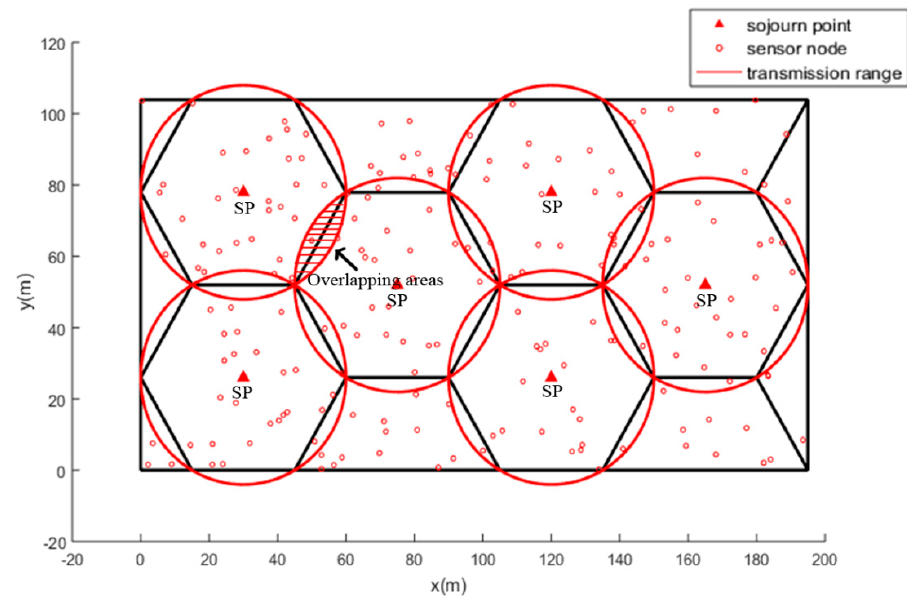
Figure 7. Hexagon Figure 7. Hexagon division.